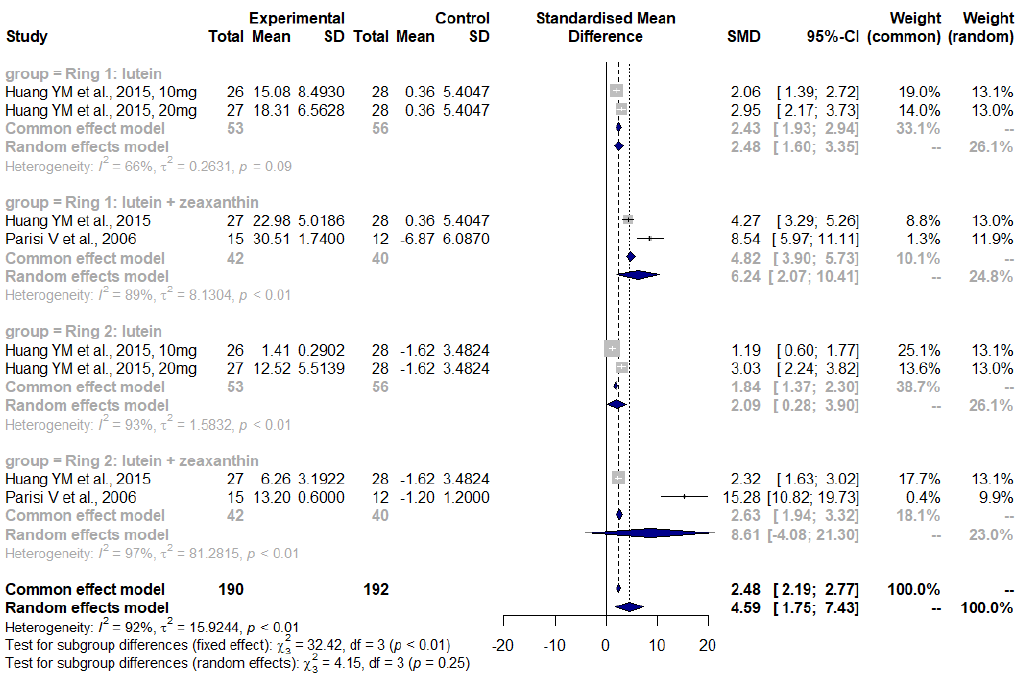
Figure 3. Forest plot of BCVA values in studies where subjects were administered either lutein or lutein plus zeaxanthin; SD, standard deviation; SMD, standardized mean difference; CI confidence interval [22,27,37].